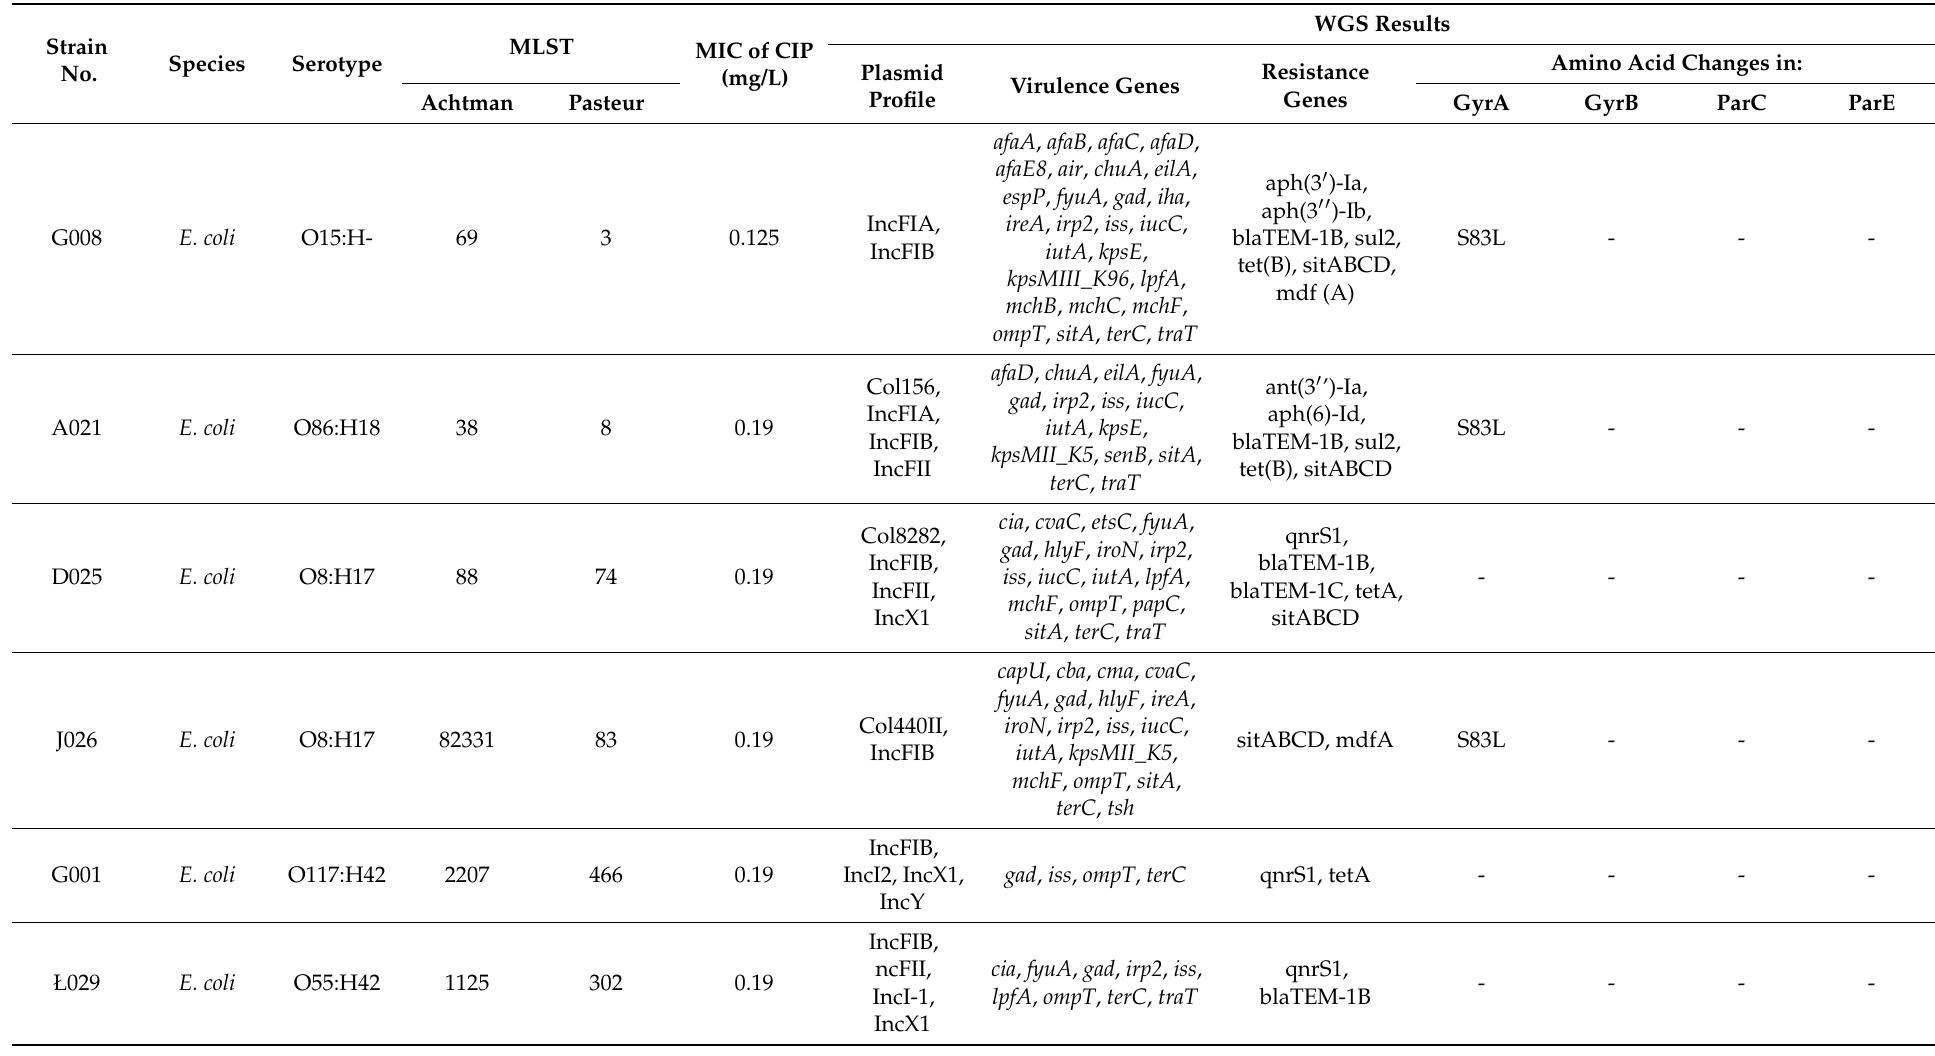
Table 2. The whole genome sequencing (WGS) analysis of 28 PMQR-producing E. coli strains isolated from rectal of men undergoing a transrectal prostate biopsy. Strain